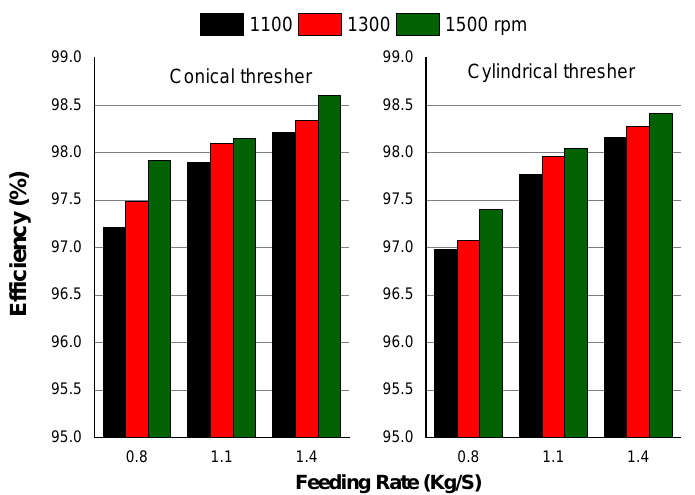
Figure 8. Effect of operating parameters on threshing efficiency.